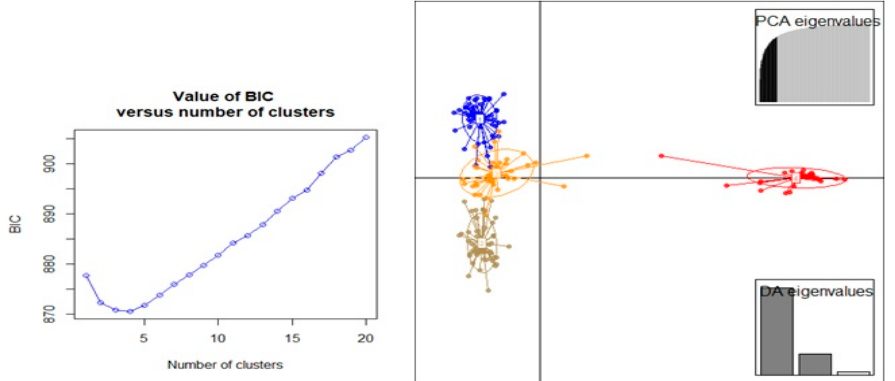
Figure 7. The percentage of cumulative variance for the retained PCA eigen vectors and scatter plot from the DAPC analysis for 186 chickpea genotypes used to determine the optimal k number of clusters using DArTseq-SNP markers.